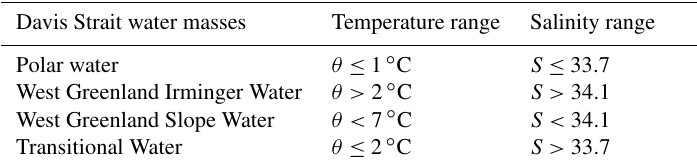
Figure 4. Average Fylla Bank temperature for June 2013 for (a) LowResControl and (b) HighRes. The magenta line shows the 2 ◦ C isotherm, the black line is the 34 . 0 salinity isohaline, and the dashed black line is the 34 . 2 salinity isohaline. Table 2. Overview of Davis Strait’s water masses. Potential temperature ( θ ) and salinity ( S ) characteristics are as defined by Curry et al.